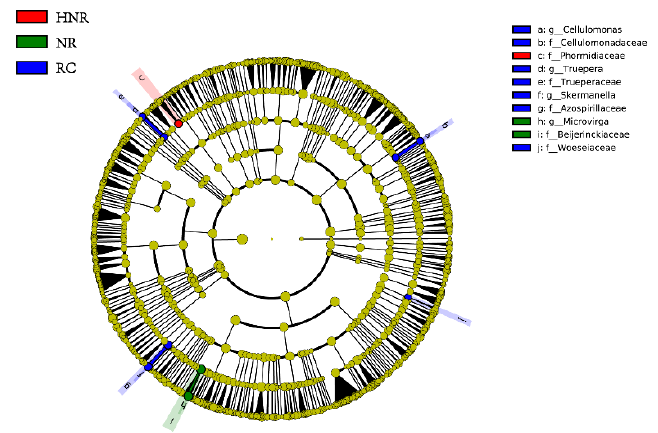
Figure 7. LEfSe analysis of the bacterial community in the study area. The Cladogram show the phylogenetic distribution of micro-organisms.